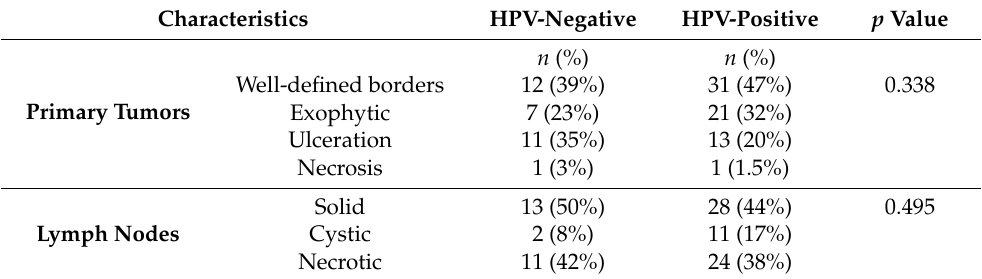
Table 2. Primary tumor and nodal morphology sorted by human papillomavirus (HPV) status. Characteristics